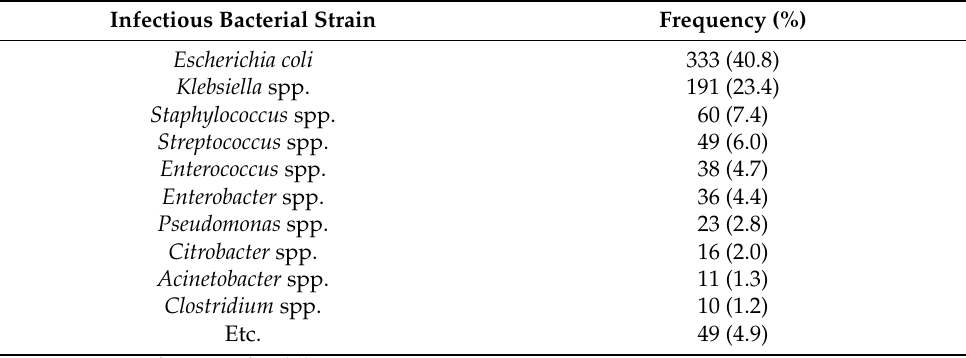
Table 2. Frequency of different bacterial strains among the culture-positive results.